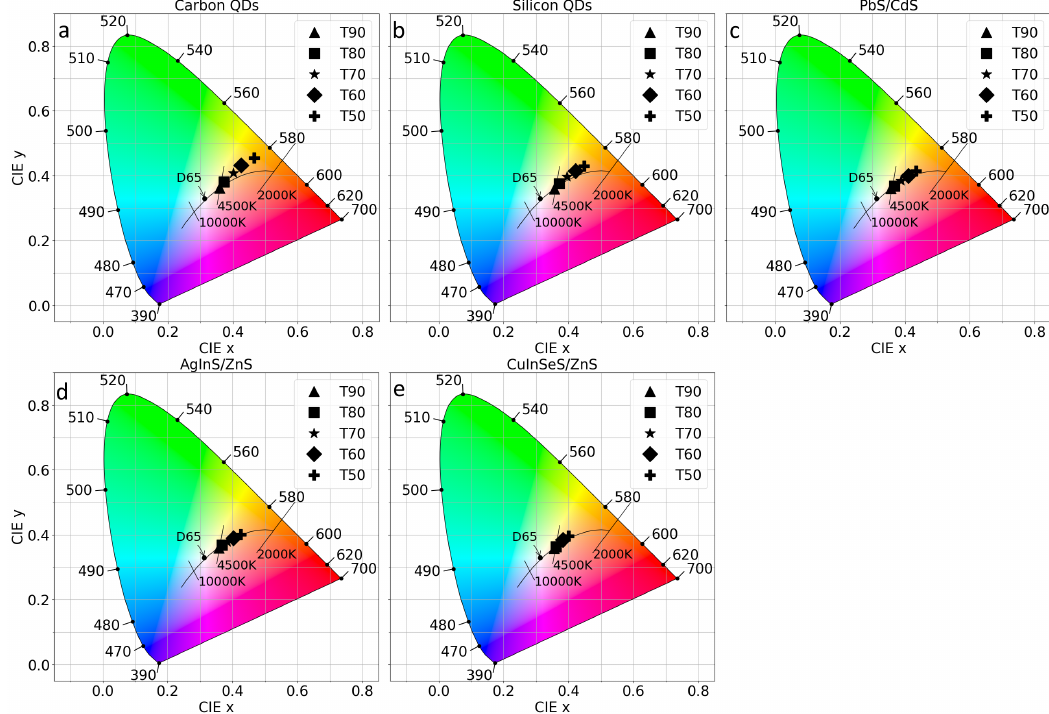
Figure 9. Chromaticity diagram showing data for the D65 illuminant when filtered through an LSC window for ( a ) Carbon, ( b ) Silicon, ( c ) PbS/CdS, ( d ) AgInS/ZnS, and ( e ) CuInSeS/ZnS